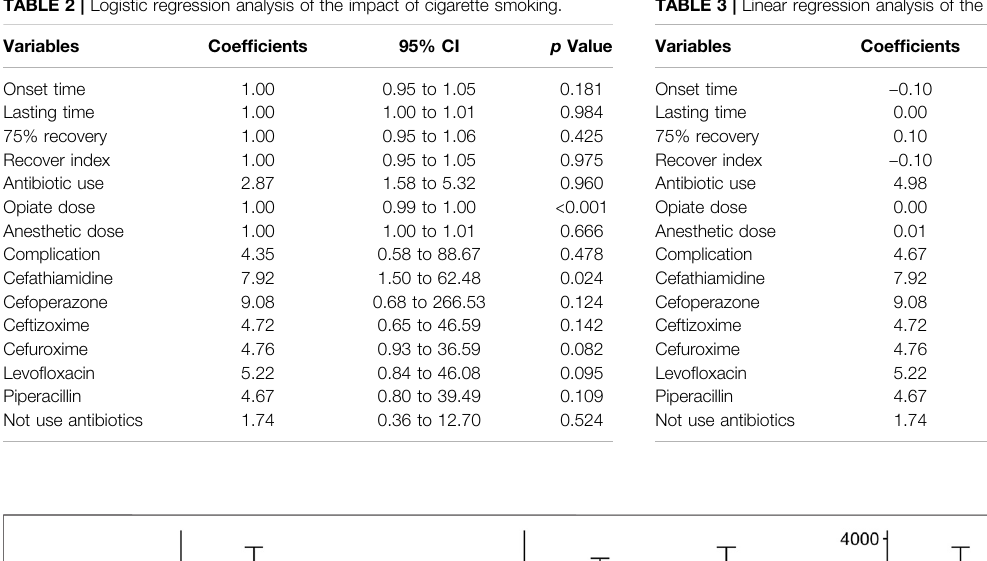
TABLE 2 | Logistic regression analysis of the impact of cigarette smoking.